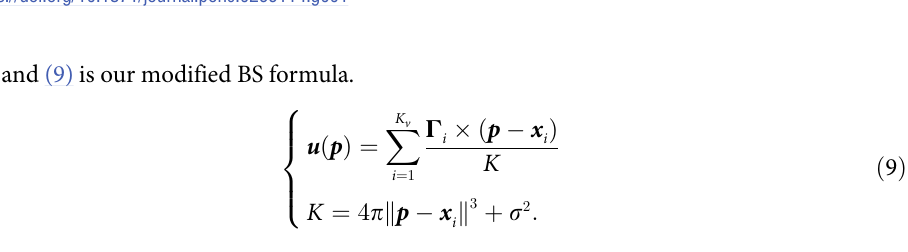
Fig 1. Induced velocity profile of the Biot–Savart formula. The horizontal axis is the distance between the inquiring position and the vortex particle, and the vertical axis is the magnitude of the induced velocity.